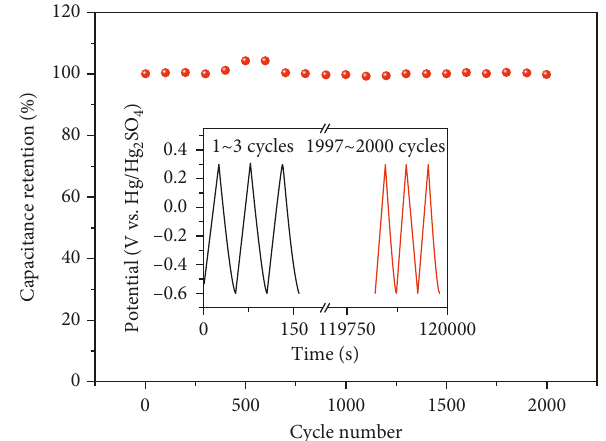
Figure 7: Cycling performance of KAC-700 under 5 A/g for 2000 cycles. The inset image shows the GCD curves in the first and last 3